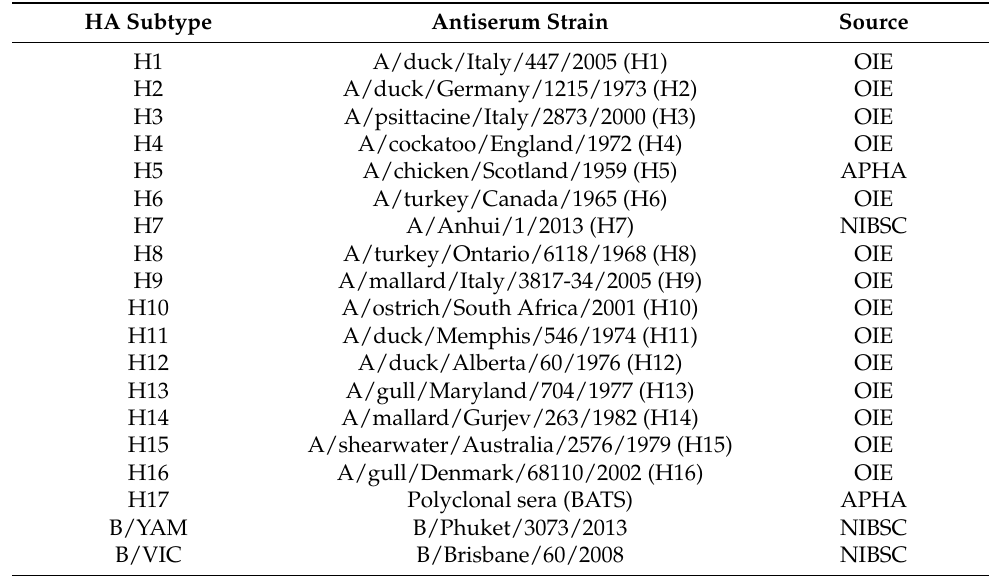
Table 2. Details of reference antisera obtained from OIE, NIBSC, and APHA for strains of IAV (H1-16) and IBV (B/Yam and B/Vic).